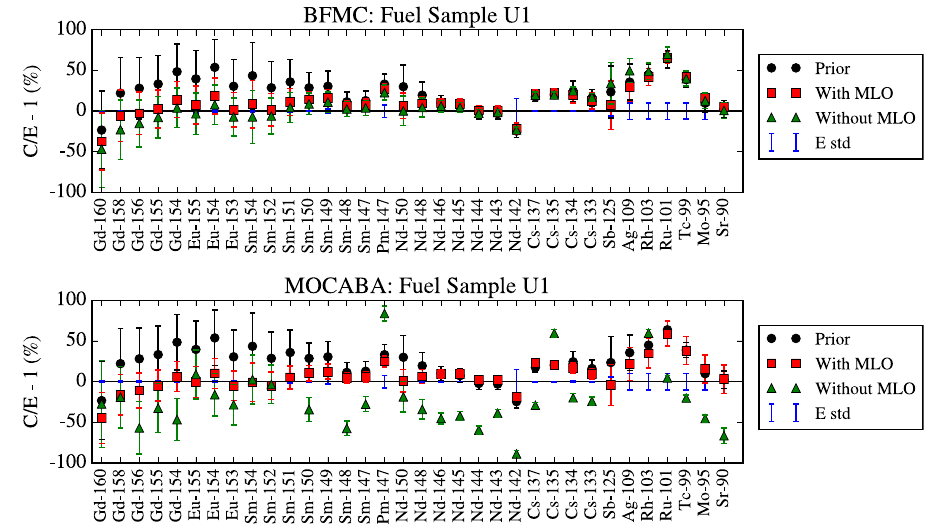
Fig. 15. Posterior biases and uncertainties of the FP concentrations obtained when MLO was and was not